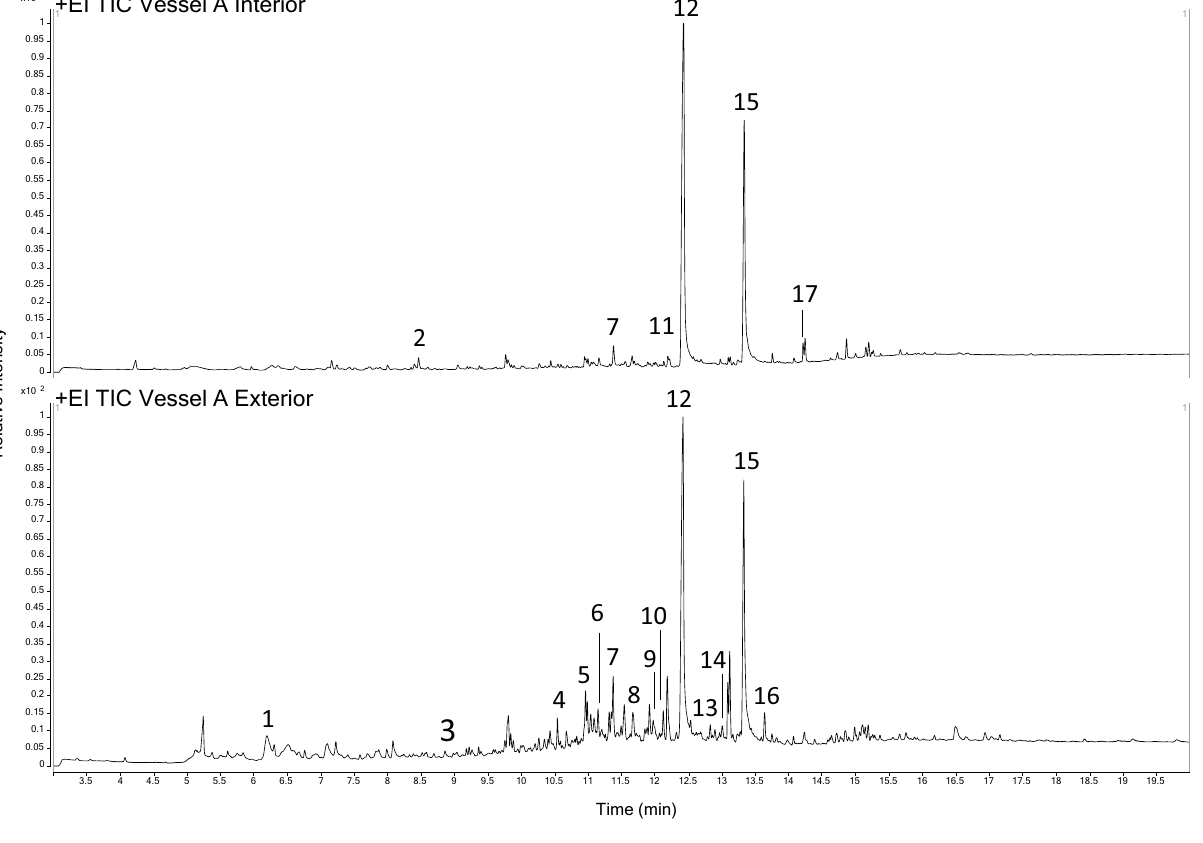
Figure 5. Total Ion Chromatograms obtained from the solid Vessel A corrosion